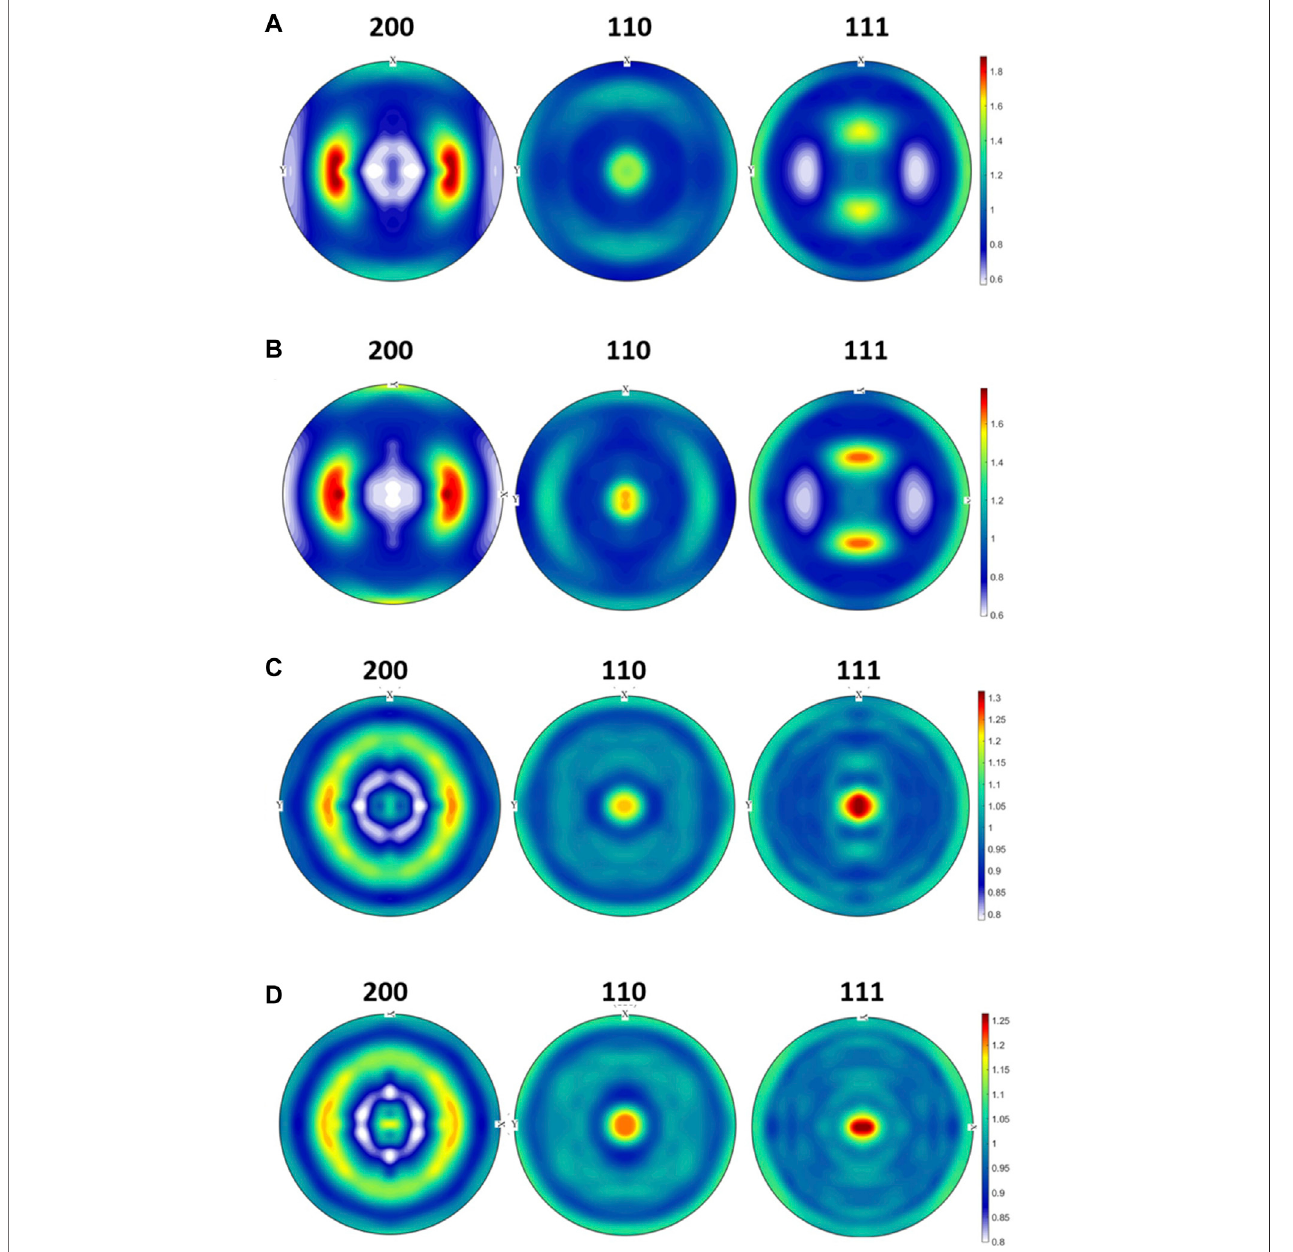
FIGURE 4 | Pole fi gures of (200), (110), and (111) poles of CR1 (A) and CR2 (B) and HT1 (C) and HT2 (D) .